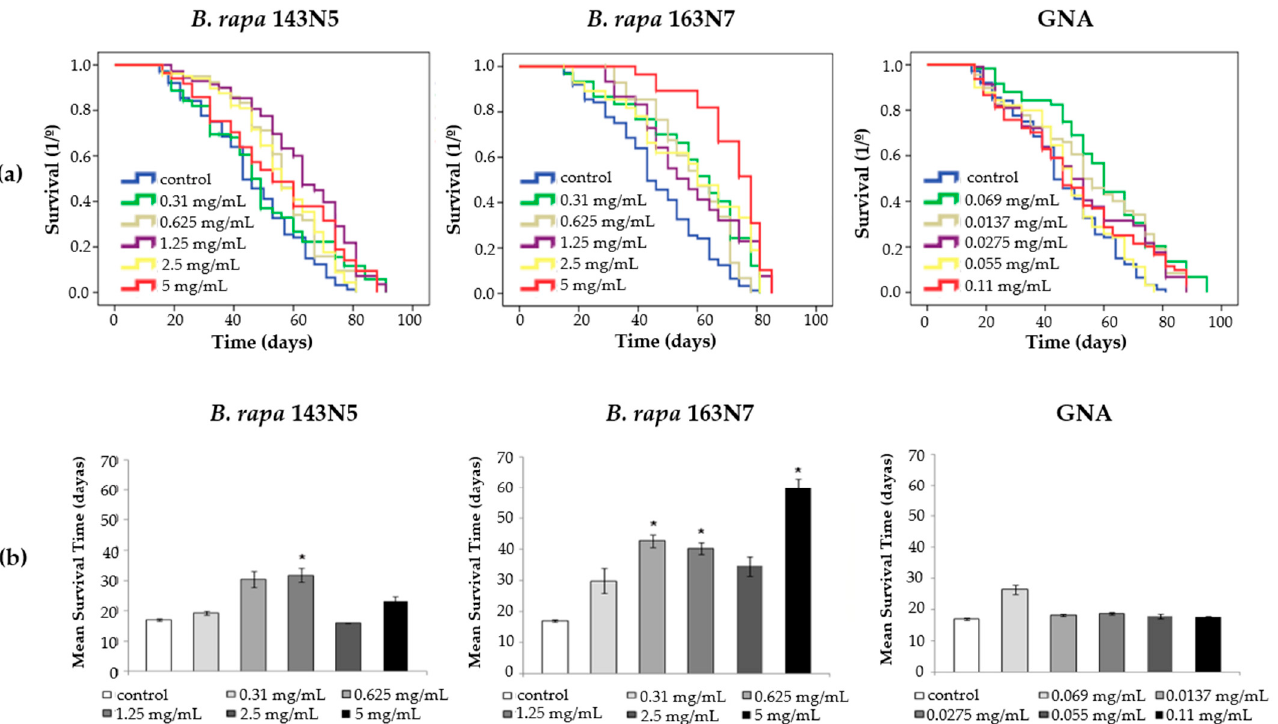
Figure 9. Effect of B. rapa cultivars 143N5 and 163N7 and gluconapin (GNA) supplementation on D. melanogaster survival: ( a ) Survival curves; ( b ) Healthspan averages (the mean of survival time, in 75% of surviving population, is shown for each concentration and sample). * significant ( p < 0.05) with respect to their control.